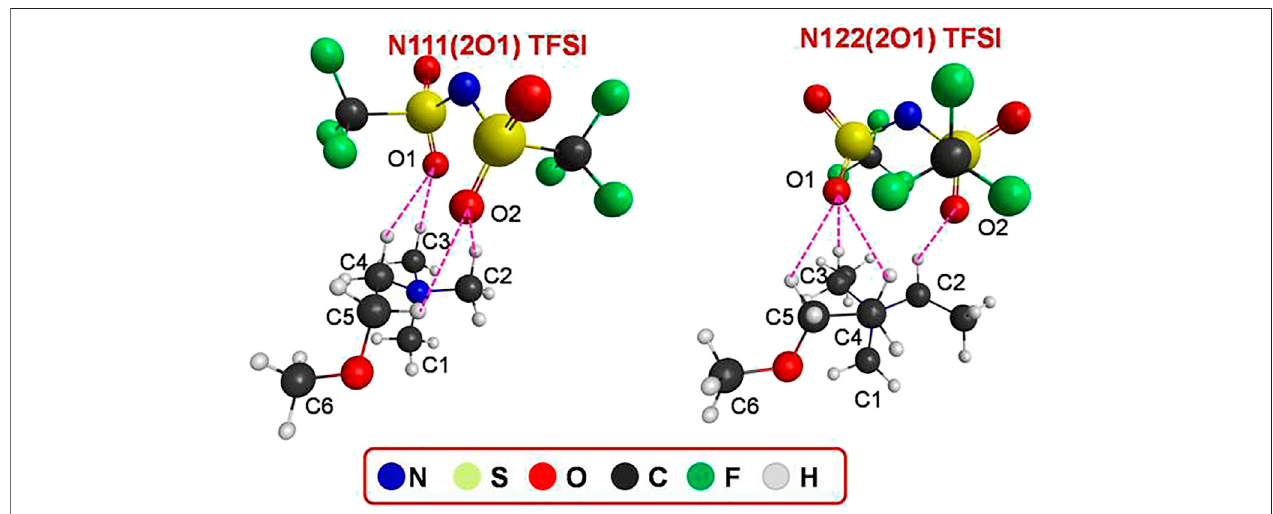
FIGURE 2 | Lowest energy con fi gurations of the two ionic couples N111(2O1)-TFSI and N122(2O1)-TFSI, as obtained by DFT calculations with 6-31G** basis set and the ω B97X-D functional, including empirical dispersion corrections and the presence of a polar solvent (dimethylformamide, ε r = 37.22).